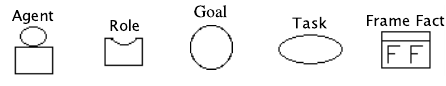
Figure 4. Main symbols of the Ingenias